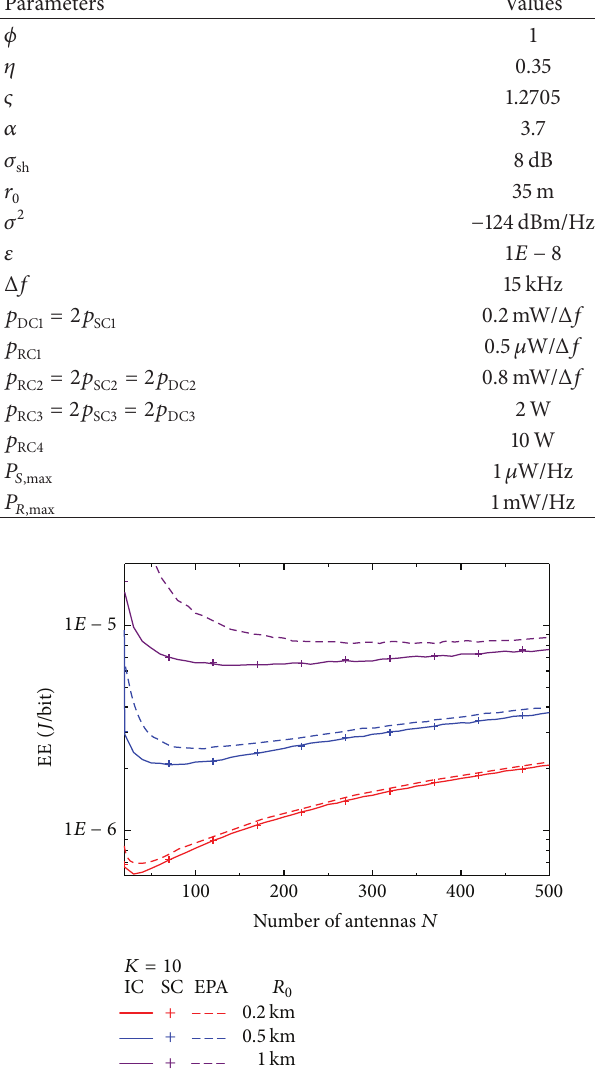
Figure 3: EE versus the number of antennas 𝑁 at the relay.